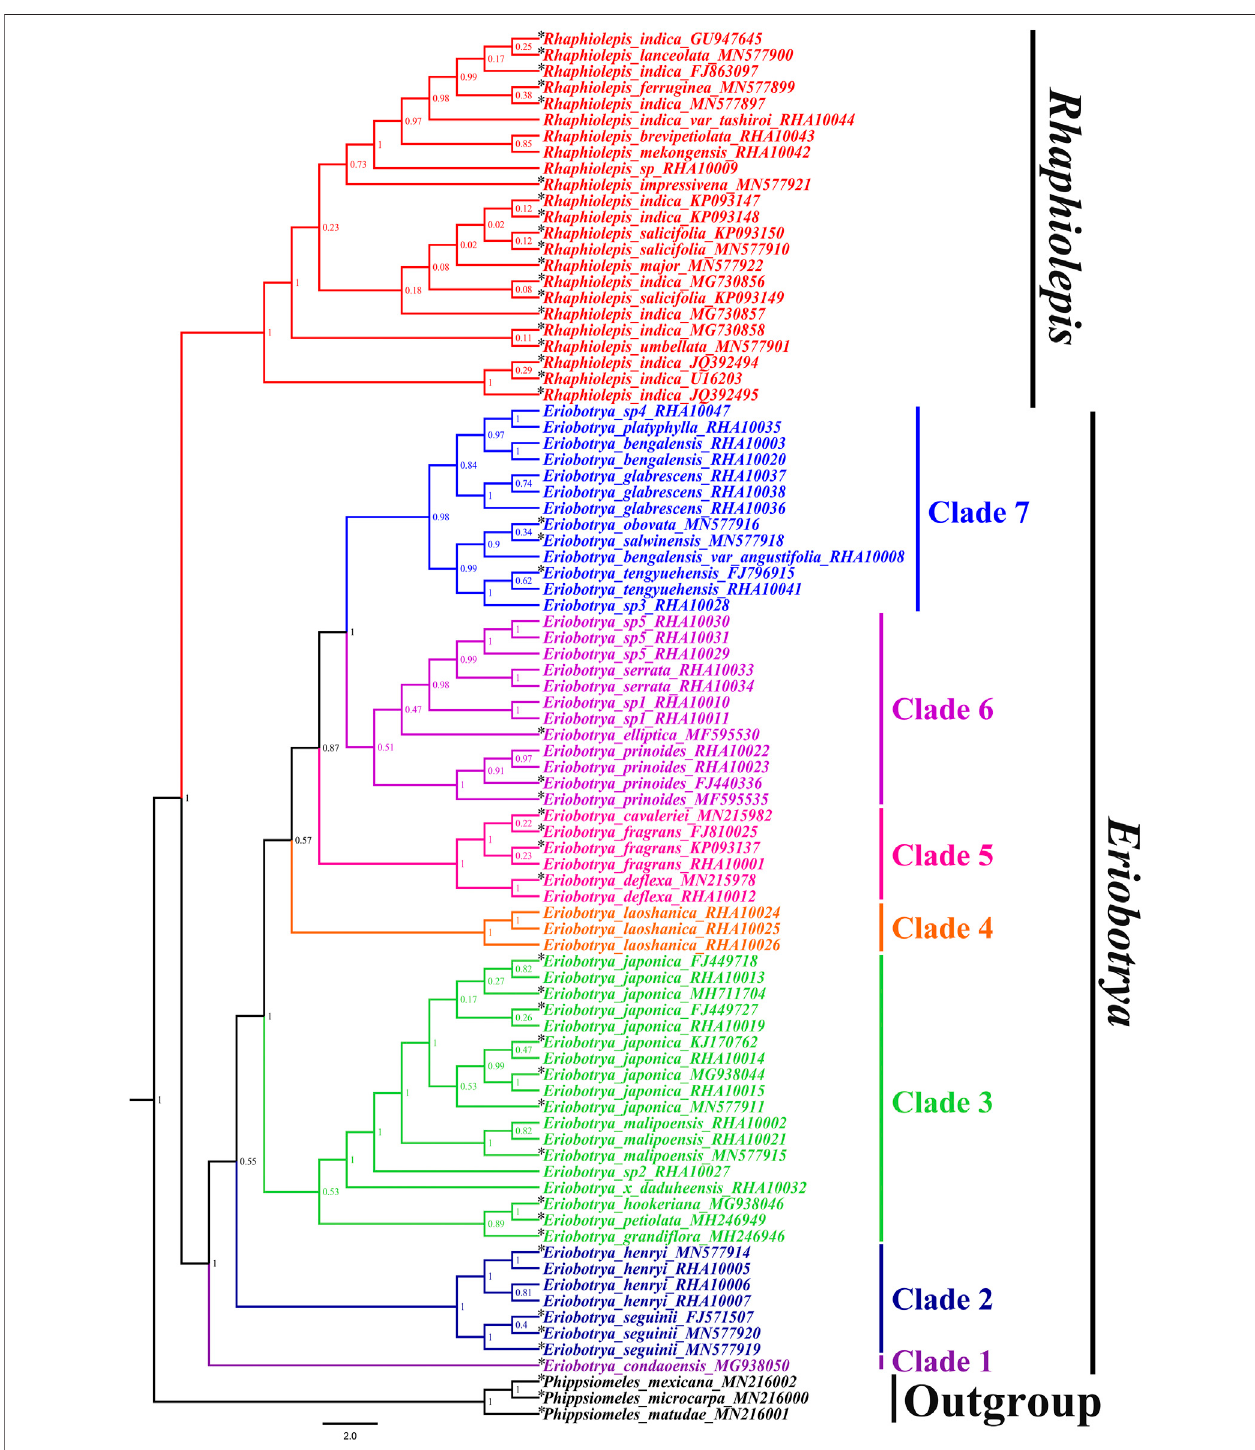
FIGURE4| Molecular phylogenetictreeof86taxaof Eriobotrya and Rhaphiolepis andthreerelated taxaof Phippsiomeles ,basedonthenrDNAsequenceandITS (containing only ITS1, 5.8S, and ITS2) sequences using Bayesian inference. Numbers at each node are Bayesian posterior probabilities. The tree is rooted with the nrDNA sequences of Phippsiomeles matudae , Phippsiomeles mexicana , and Phippsiomeles microcarpa . The asterisks (*) indicate the sampling in NCBI.